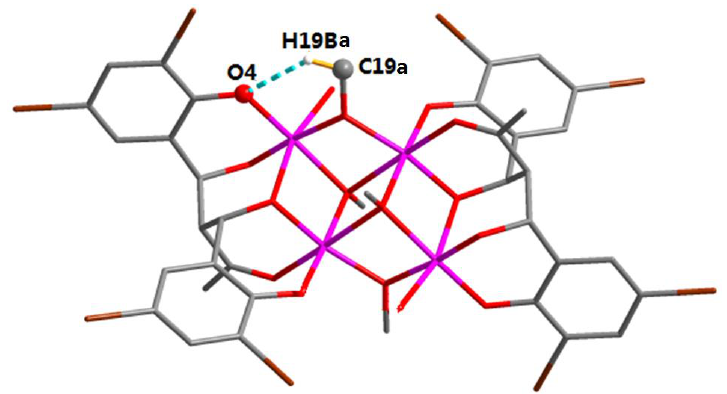
Figure 11. Part of intramolecular C–H···O hydrogen-bonding interactions in Mn III complex 3 (symmetry codes: a = 1 − x, 1 − y, 1 − z).